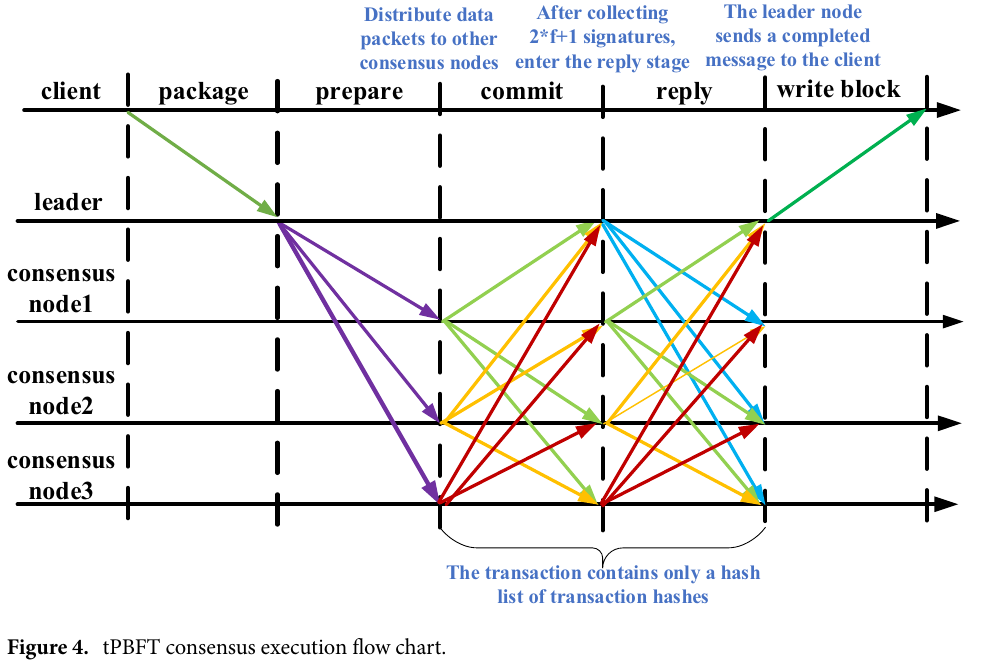
Figure 4. tPBFT consensus execution flow